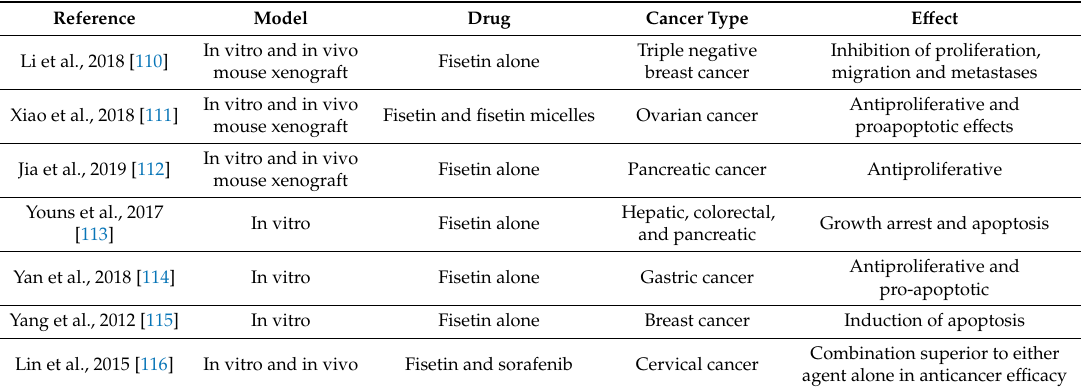
Table 4. Table summarising studies of fisetin in